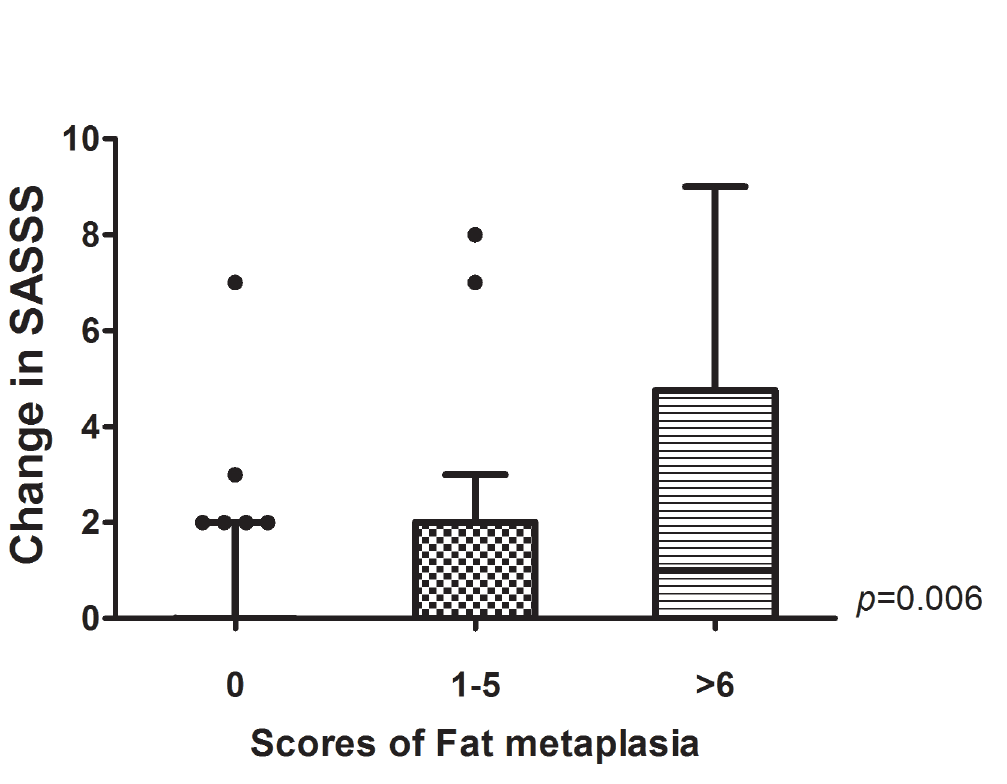
Fig 1. Radiographic progression according to the severity of fat metaplasia on baseline sacroiliac joint (SIJ) MRI. Spinal radiographic progression (scored according to the SASSS) was significantly greater in patients with severe fat metaplasia on baseline SIJ MRI after adjusting for baseline SASSS and TNF inhibitors treatment. P values were calculated using an analysis of covariance model, with the severity of fat metaplasia at baseline as a factor and the baseline SASSS and TNF inhibitors treatment as covariates. The bottom and top of the box were the first and third quartiles, and the band inside the box was the median. The ends of the whiskers represented 1.5